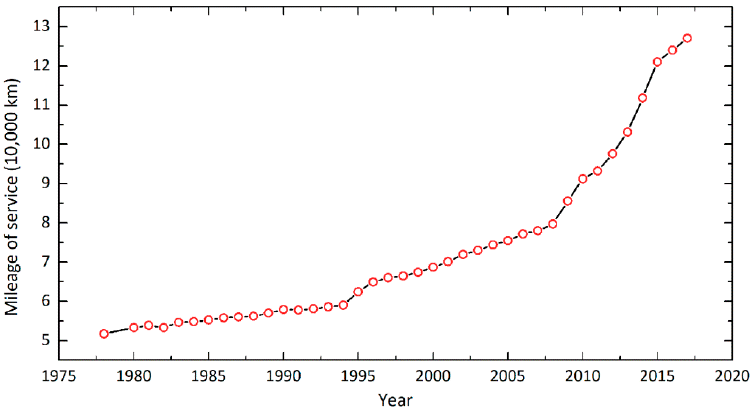
Figure 1. Mileage of China’s railway service.